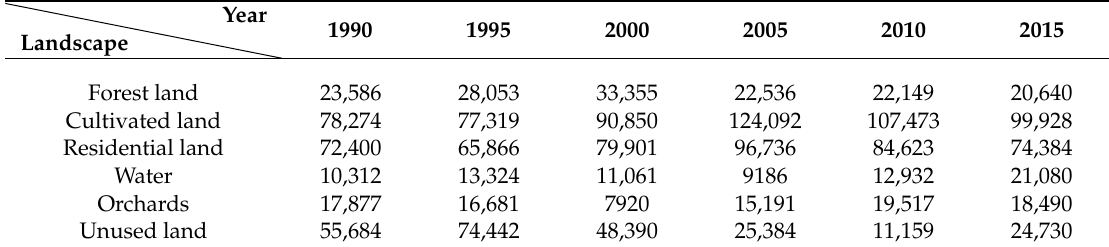
Table 13. Number of patches (NP) for various types of landscape.